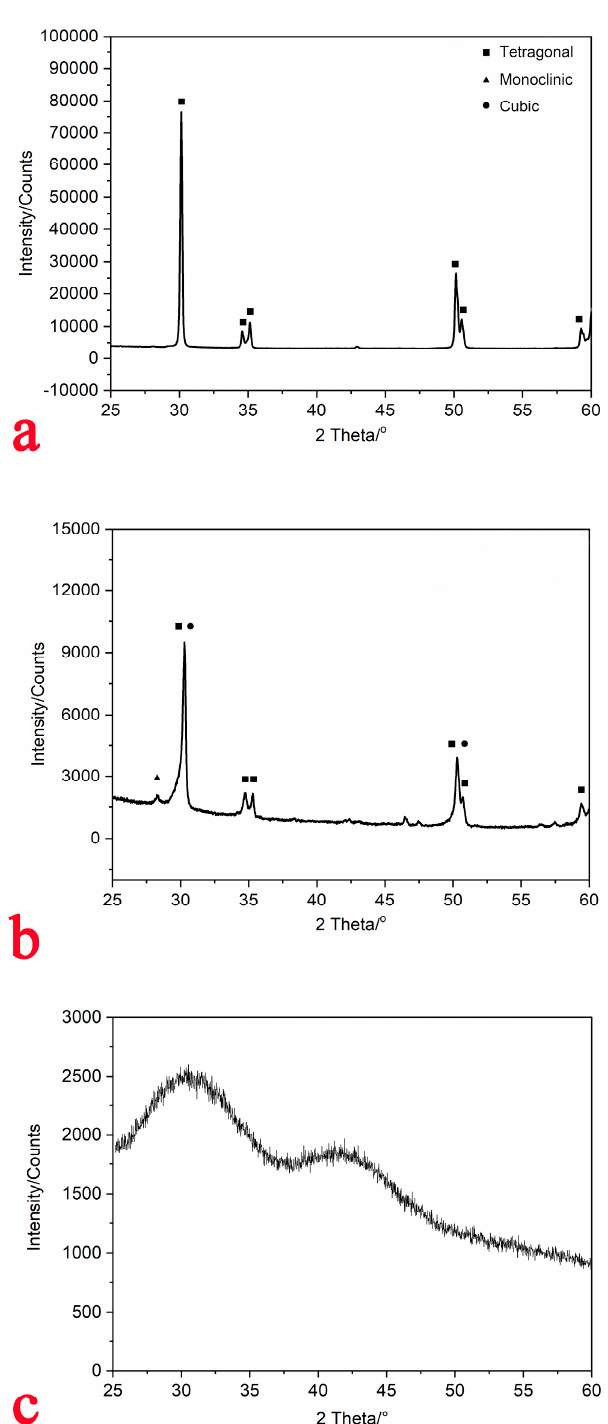
Figure 4. XRD images of zirconia surface from different groups: ( a ) For NT (no treatment group), the zirconia surface for NT was completely tetragonal-phase; ( b ) for APA (airborne particle abrasion group), the tetragonal phase ratio of the surface was low, with a small amount of monoclinic and cubic phases; and ( c ) for FSL (femtosecond laser group), there may be an amorphous phase, as it was also possible to form salt crystals on zirconia surfaces treated with FSL.